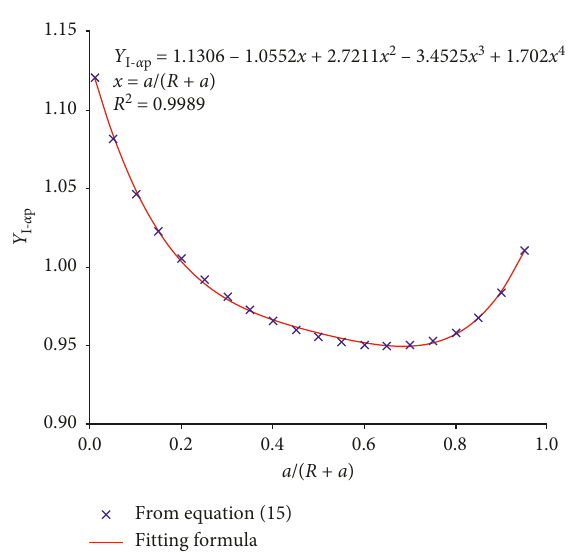
Figure 5: Normalized mode-I stress intensity factor caused by pore pressure.